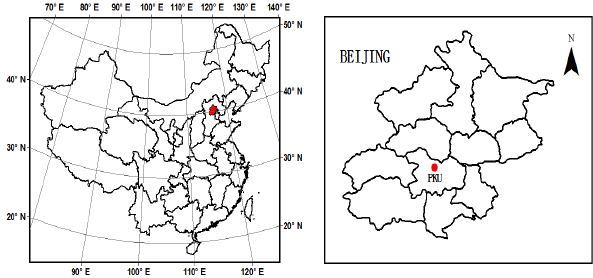
Figure 1. The location of Beijing city in China and the sampling site in